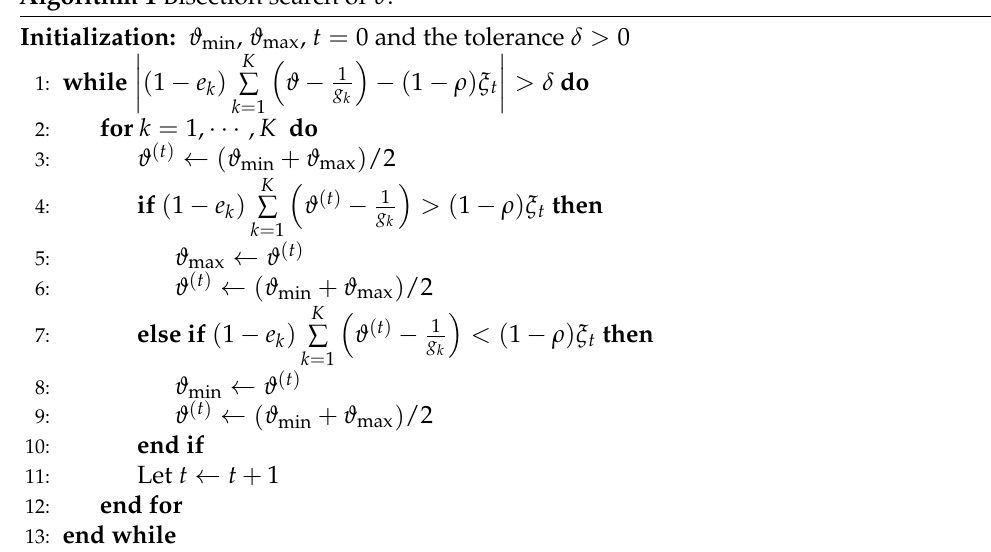
Algorithm 1 Bisection search of ϑ